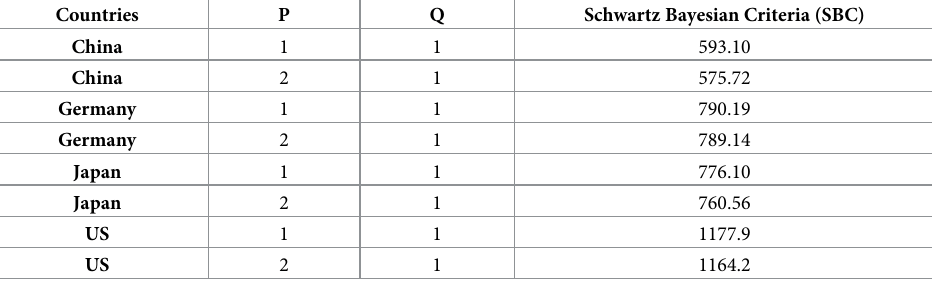
Table 8. Order of VARX �